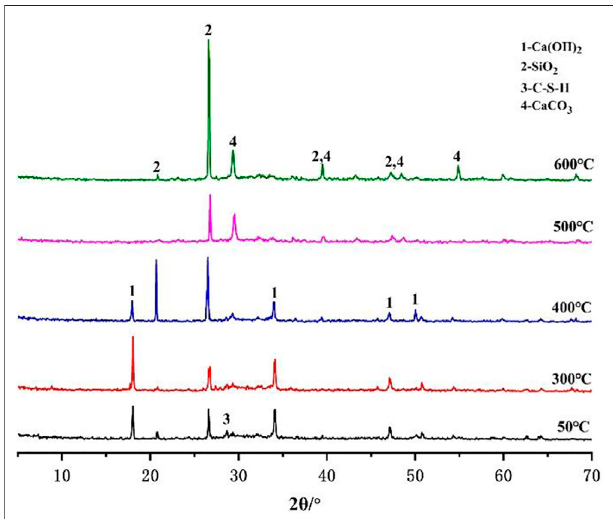
FIGURE 9 | XRD diffraction patterns of C3 cement paste under different curing environments.